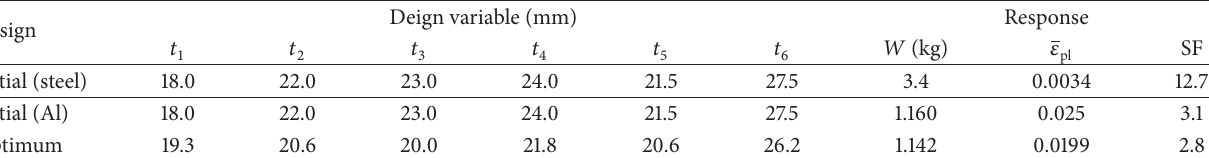
Table 6: Responses at initial and optimum designs.